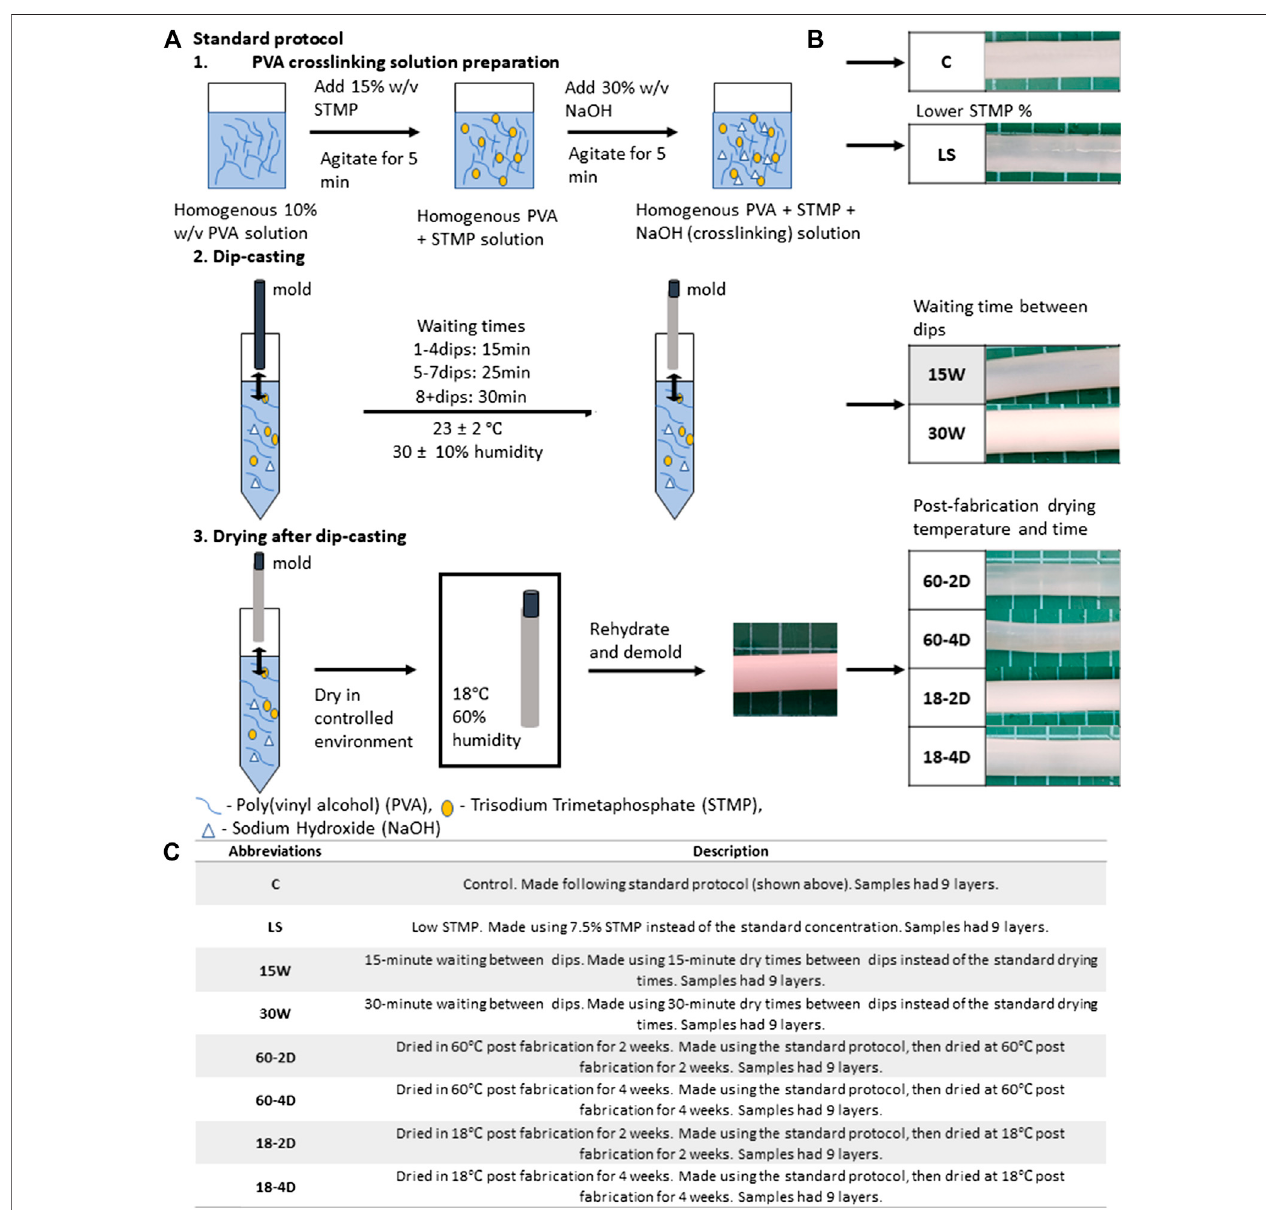
FIGURE 1 | Standard graft fabrication protocol and description of the varied parameter for each experimental groups. (A) Standard protocol, (B) representative imagesofthefabricated grafts foreach experimental group, and (C) abbreviationsand descriptions ofthevaried parameter foreach experimentalgroup. Samplesforall groups were fabricated following the standard protocol except for the described